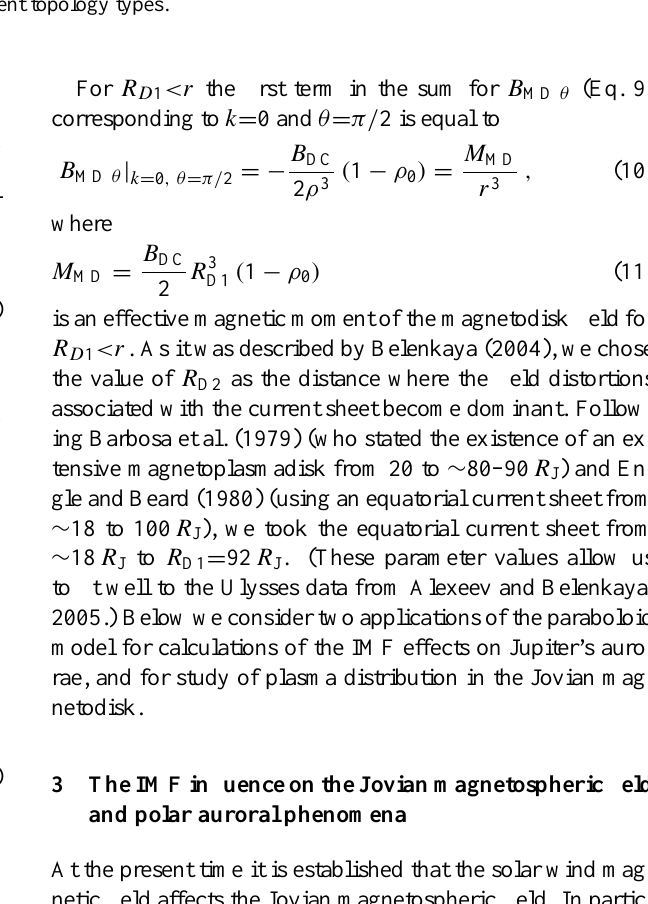
Fig. 1. Noon-midnight meridional cross section of the open Jovian magnetosphere for northward IMF ( B IMFx =− 0 . 02nT; B IMFy = 0nT; B IMFz = 0 . 62nT) with κ J = 0 . 8. The model parameters are: ψ = 0; R ss = 100 R J ; R 2 = 65 R J ; B t =− 2 . 5nT; R D 1 = 92 R J ; R D 2 = 18 . 4 R J ; B DC = 2 . 5nT. Dashed curves separate magnetic field lines of different topology